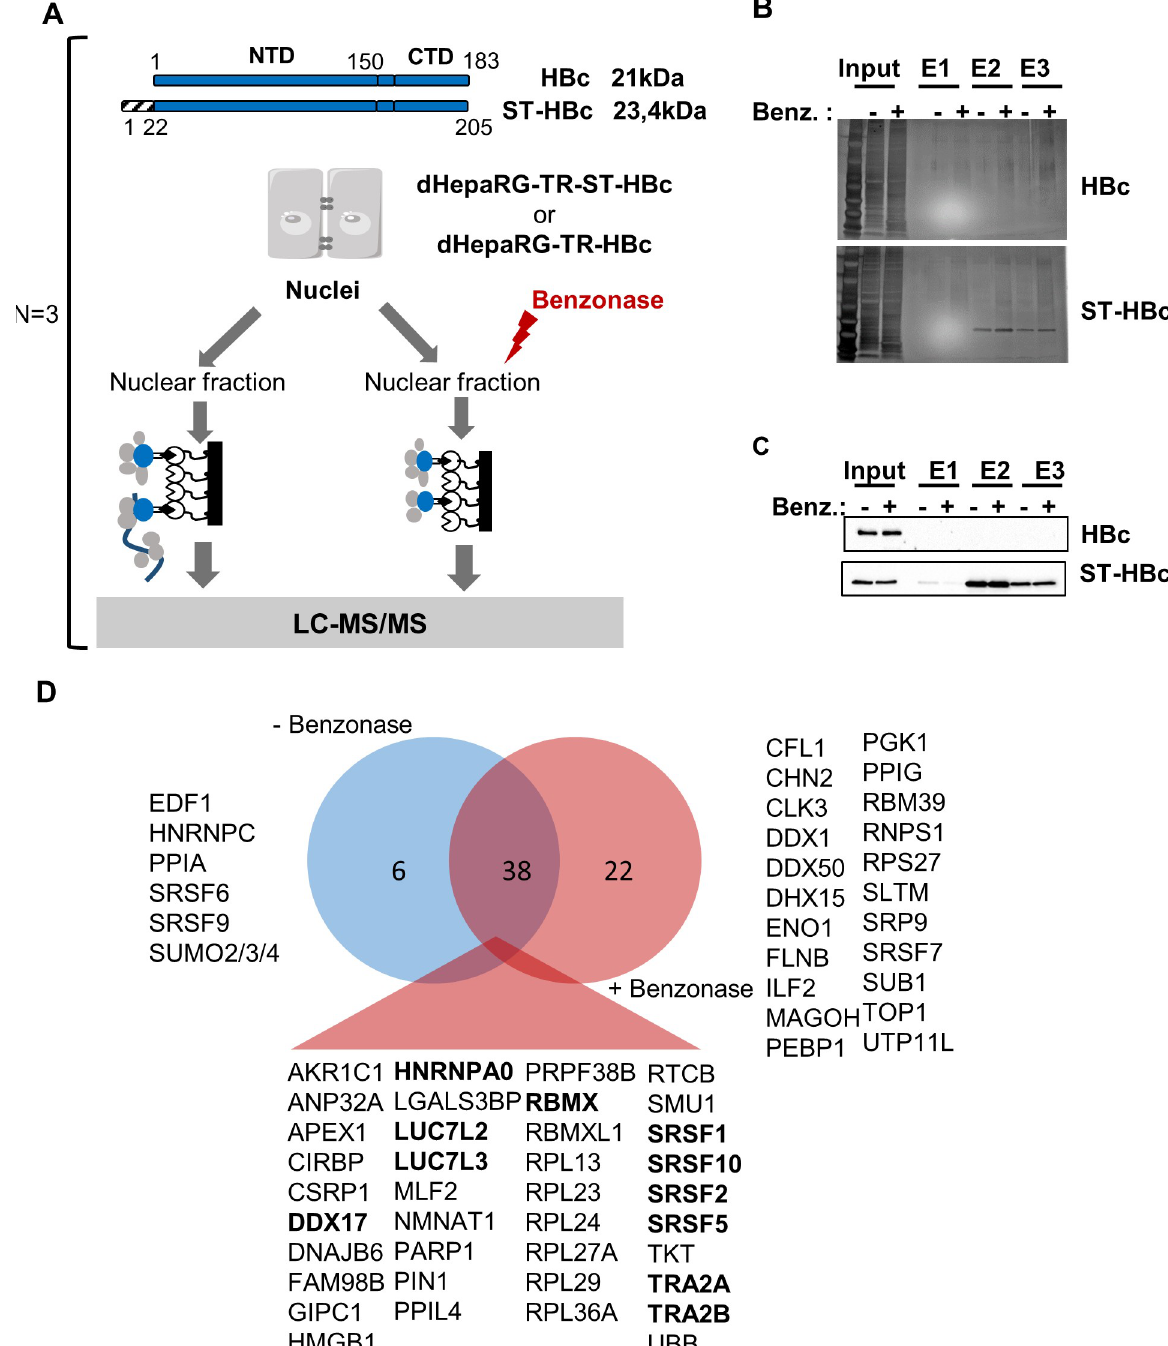
Fig 1. Identification of HBc-interacting proteins in the nucleus of dHepaRG cells. (A) Schematic view of HBc purification process. Nuclei were purified from differentiated HepaRG-TR cells (dHepaRG-TR) expressing either wt HBc or ST-HBc under the control of a tetracyclin-inducible promoter, lysed and then treated or not with Benzonase. Nuclear extracts were purified on a Streptactin column and protein eluted with desthiobiotin. Input and eluted fractions (E1, E2, and E3) were analyzed by gel electrophoresis followed by silver staining (B) and western blot (C) using an anti-HBc antibody. (D) Venn diagram of proteins significantly associated to HBc common to conditions with and without Benzonase. Proteins in bold correspond to the 11 “founders” RBP common to both conditions (see text, RBMXL is not highlighted because it was considered as a retrogene of RBMX).